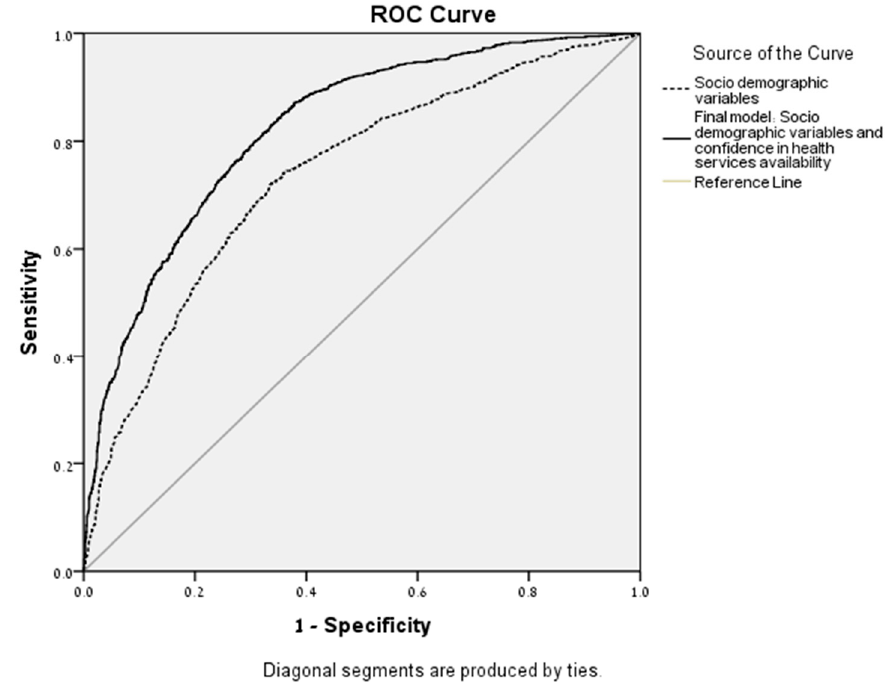
Figure 2. Receiver operating characteristic (ROC) curves of the socio-demographic variables compared with final model including confidence in health services availability during emergencies.